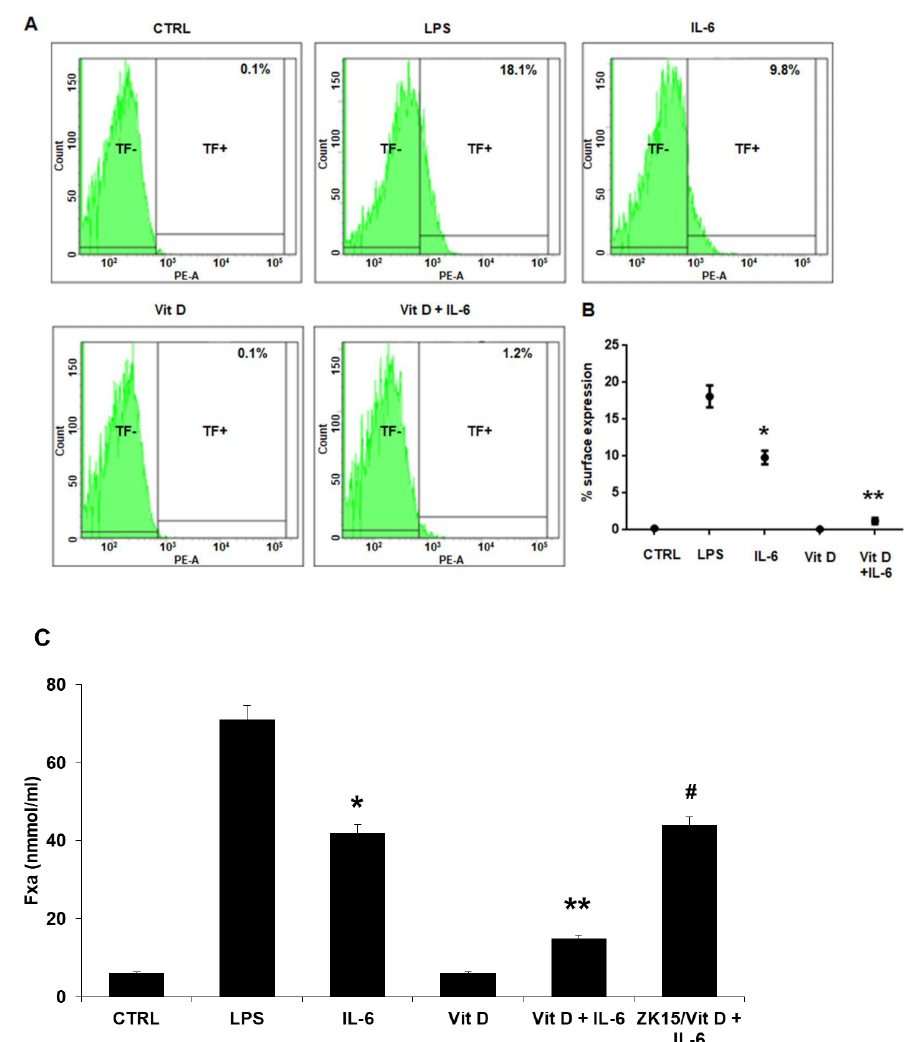
Figure 2 . ( A ) FACS analysis showed that IL-6 induced TF expression on cell surface. In controls (CTRL) and in cells cultivated with VitD alone, TF was almost not detectable on membranes (0.1%). Stimulation with IL-6 caused TF+ in 9.8±1.8% of cells. In IL-6-treated cells preincubated with VitD, TF+ cells were reduced to 1.2±0.8%. LPS served as positive control (up to 18% TF + cells; * p < 0.001 vs. Control; ** p < 0.001 vs. IL- 6 with Tukey’s post hoc test). ( B ) Graph of FACS analysis experiment. Each point represents the mean ± SD of 6 experiments. ( C ) Effects of VitD on IL-6-induced TF activity evaluated by a two-step colorimetric assay based on the ability of TF/FVIIa to promote generation of coagulation FXa. IL-6-induced-TF activity reflects results observed for TF expression, confirming that TF was functionally active. VitD preincubation significantly reduces TF activity. The use of ZK15 abolished the VitD effect. LPS served as positive control. Each column represents the mean ± SD of 6 experiments in triplicate (* p < 0.001 vs. Control; ** p < 0.001 vs. IL-6, # p = NS vs. IL-6; one-way ANOVA with Tukey’s post hoc